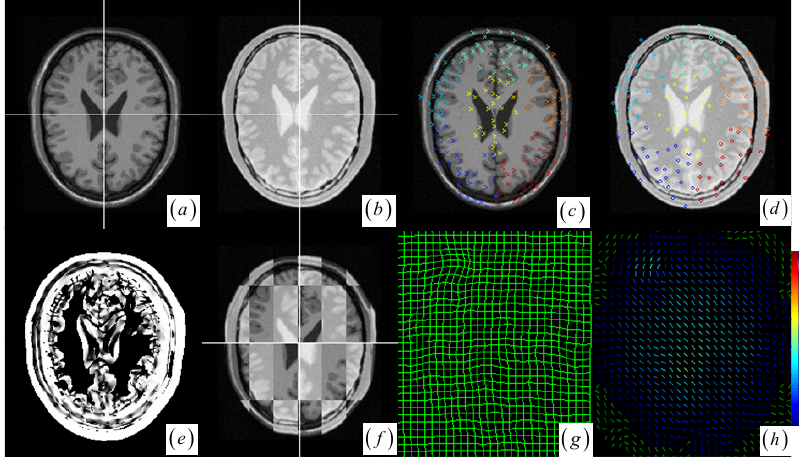
Figure 7. (a)–(b) The MR-T1 and MR proton density weighted images. (c)–(d) Significant keypoints selected from the different clusters. (e) JSM between the two images. (f) Fused image using check pattern after registration. (g) Warped mesh after registration. (h) Displacement vector